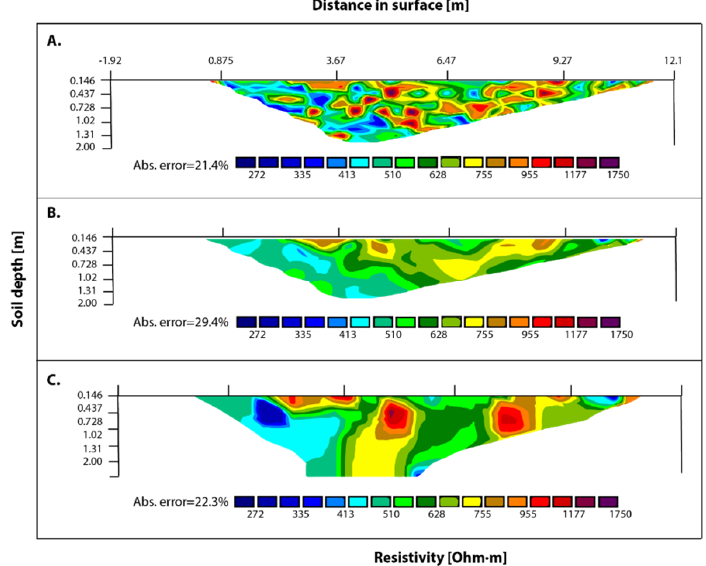
Figure 5. Inverse model resistivity section plots of three assessed farms in three municipalities of Boyacá. · m); ( B ) Muzo (1616 Ohm · m); and ( C ) Pauna (1718 Ohm · ( A ) Maripí (1638 Ohm·m); ( B ) Muzo (1616 Ohm·m); and ( C ) Pauna (1718 Ohm·m). Boyac á . ( A ) Marip í (1638 Ohm